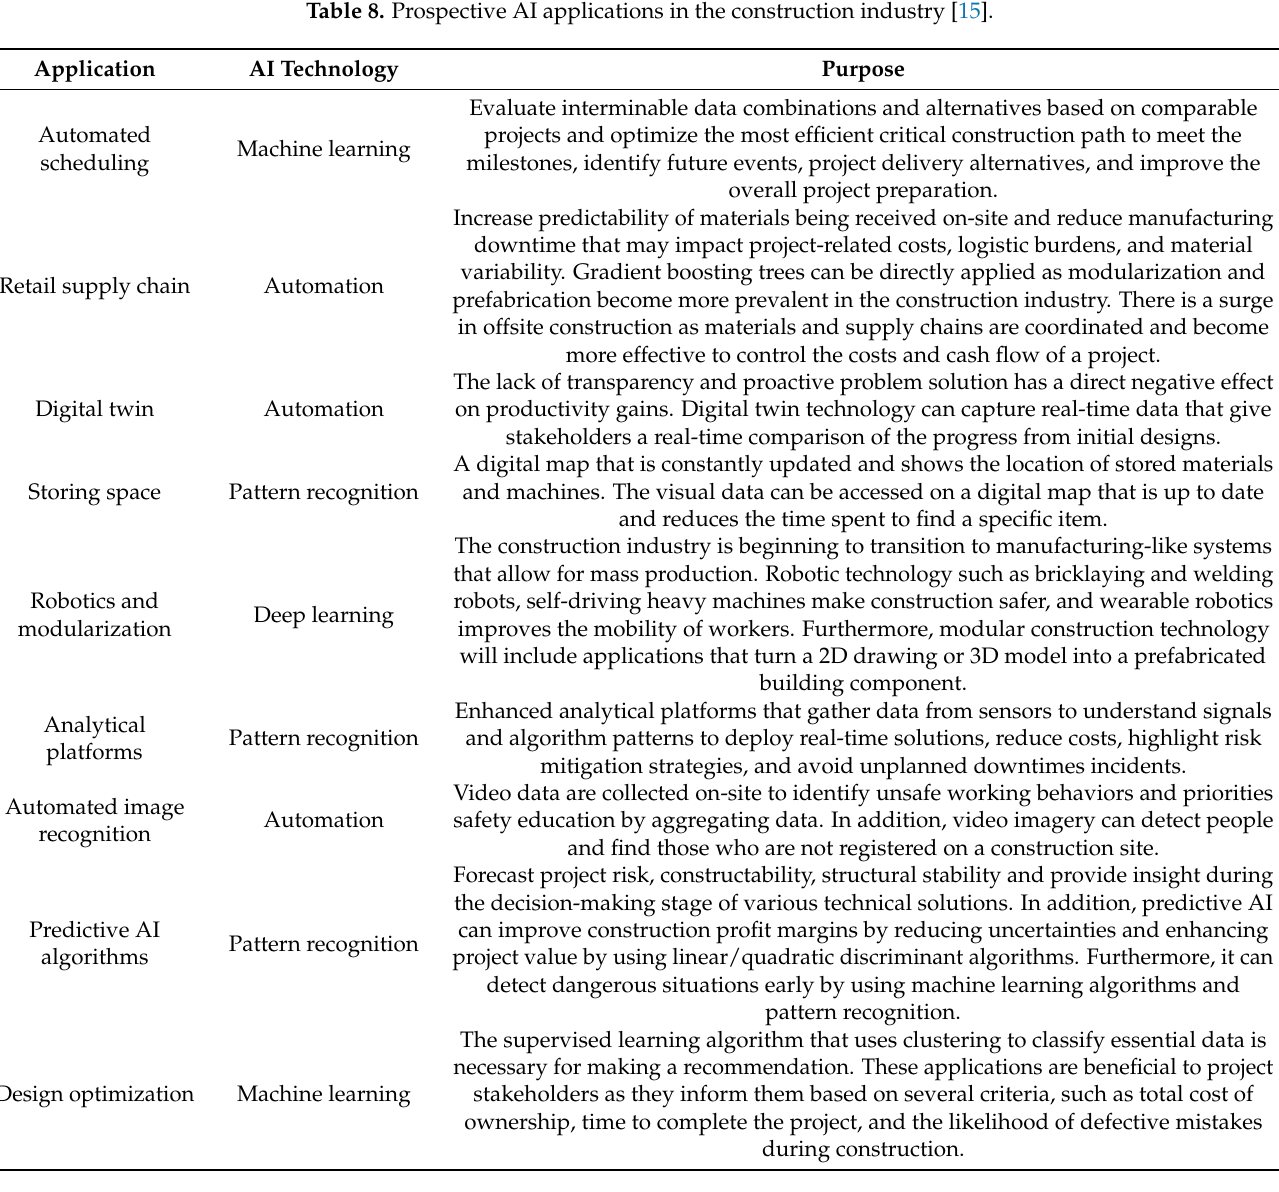
Table 8. Prospective AI applications in the construction industry